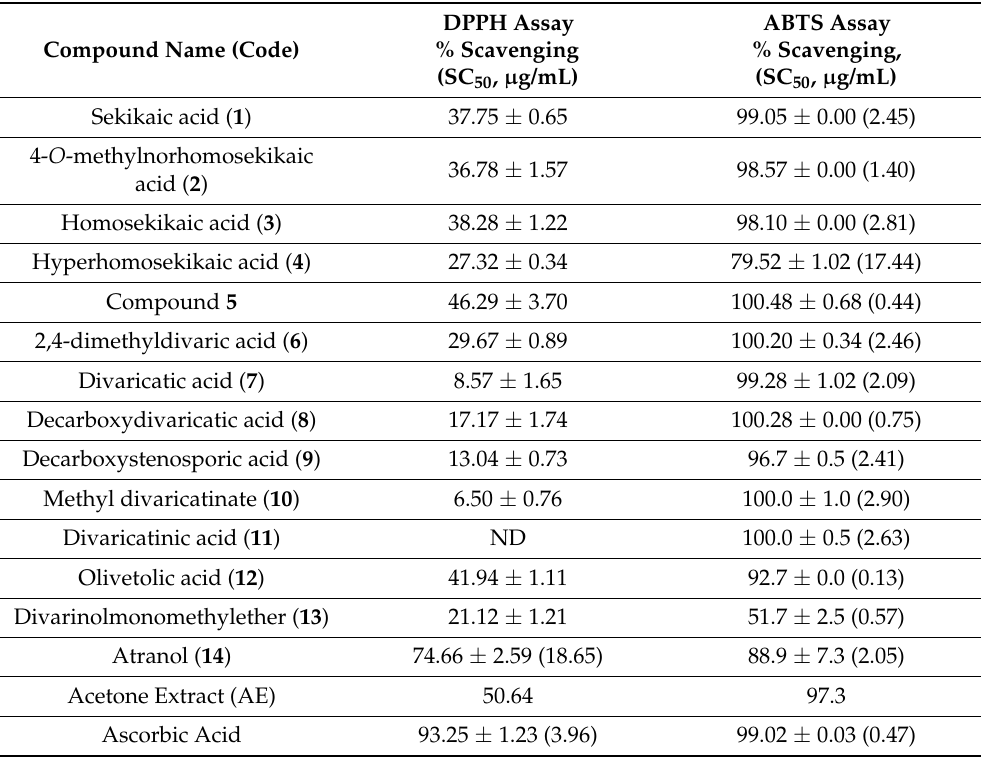
Table 2. Free radical scavenging activities of AE and compounds ( 1 – 14 ) of Ramalina conduplicans .